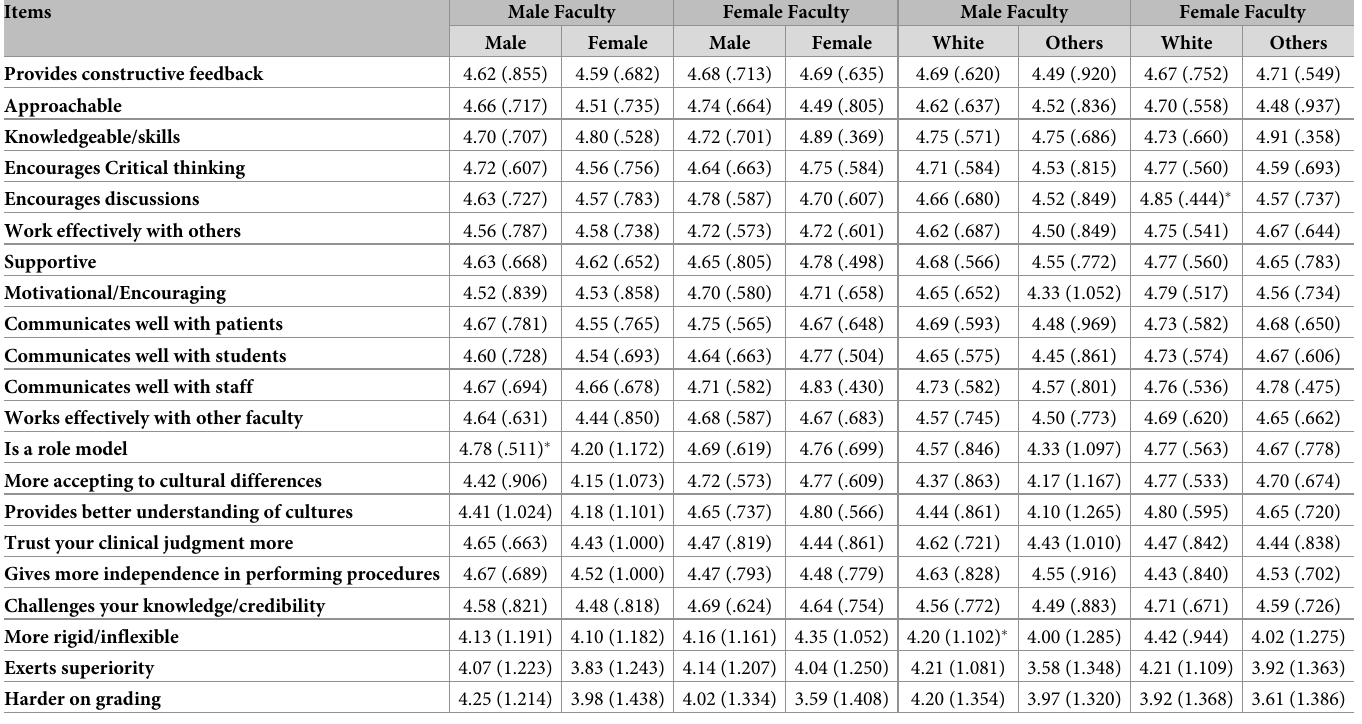
Table 4. Student’s mean (SD) perception scores for male and female faculty according to student’s gender and ethnicity. Items